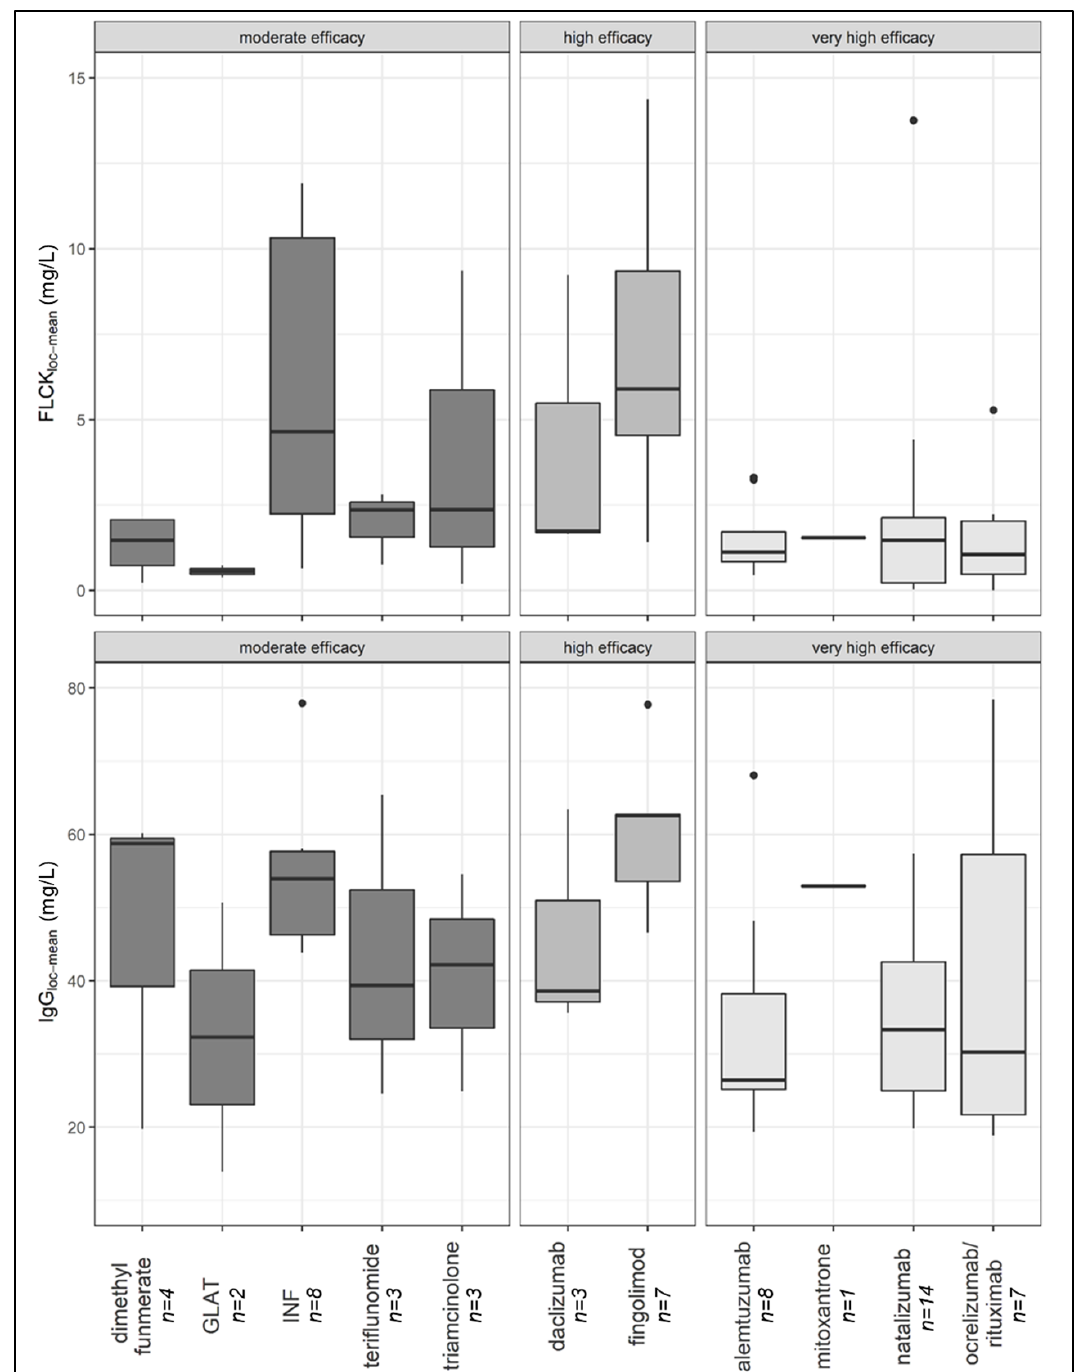
Figure 2. Data of local FLCκ concentrations of patient samples presented in box plots (median, first, and third quartile). Samples from patients treated with very high effective DMT had significantly lower FLCκ concentrations than samples treated with high effective DMT ( p = 0.004) and the control group ( p < 0.0001). DMT—disease-modifying therapy, FLCκ—free light chains kappa . Comparison between groups was performed using the Kruskal–Wallis test. The Dunn–Bonferroni test was used for post hoc analysis.